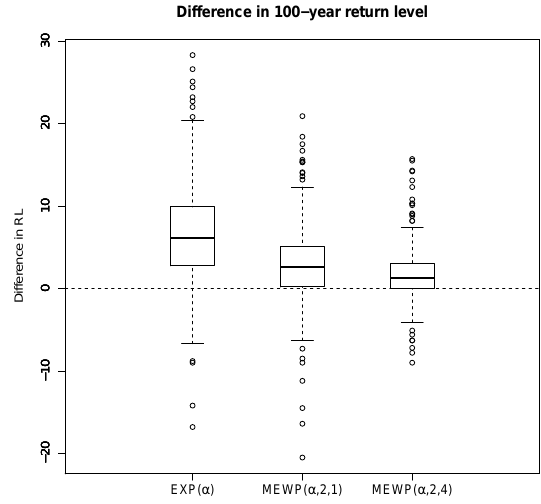
Figure 9. Box plot of the difference (inmm) between the 100-year return levels of MEWP (α, 2 , 8 ) and the three other EXP-based mod- els, for α = 0 . 5 (one point per station and